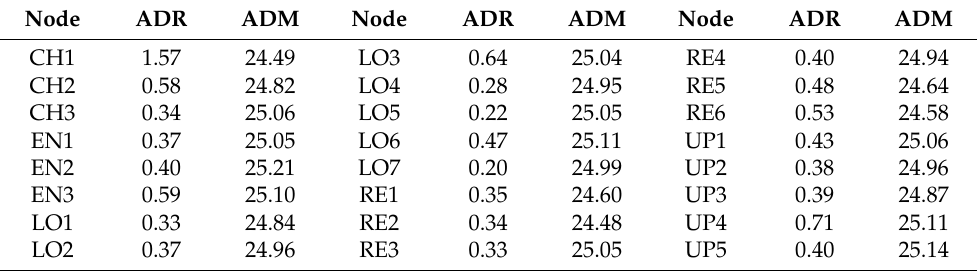
Table 3. Summary parameters of temperature for 24 nodes: average of daily ranges (ADR, ◦ C) computed from day 1 to 212 and average of daily median (ADM, ◦ C) up to day 130.